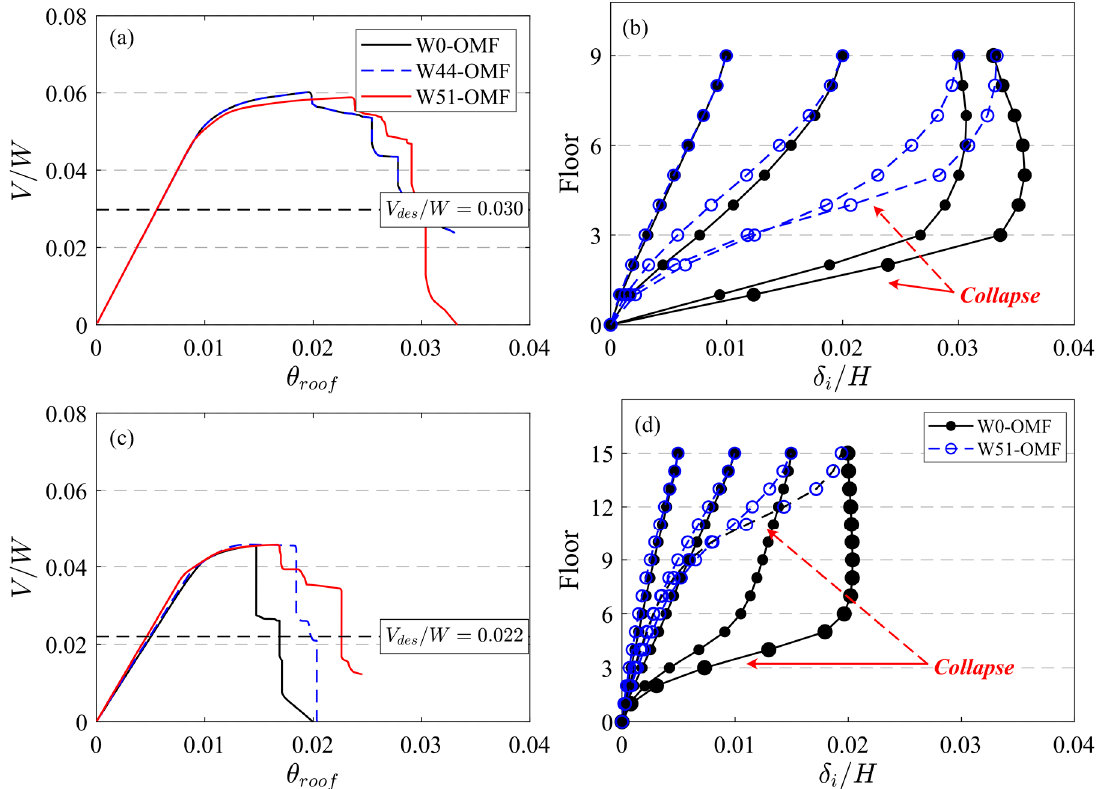
Figure 4. Result of pushover analysis for 9- and 15-story steel OMFs: ( a , c ) Pushover curves; ( b , d ) nor- malized floor displacement ( δ i / H ) of W0- and W51-OMFs at specific normalized roof displacements until collapse